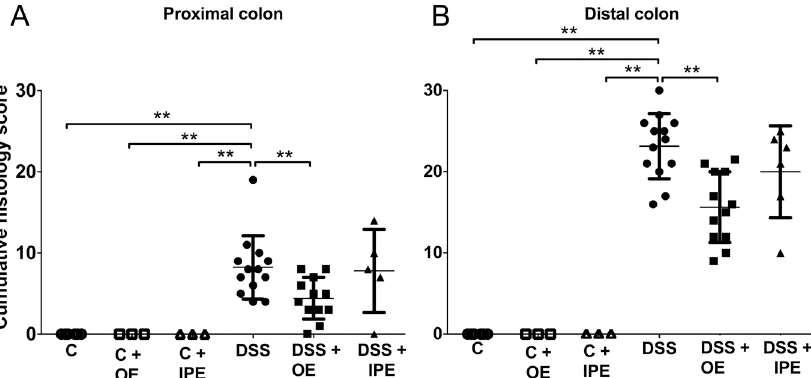
Fig 4. Effect of enoxaparin on histological changes of colon. Cumulative histology damage scores for (A) proximal colon and (B) distal colon. Results are expressed as mean ± SD of n = 3 – 14 mice. ** p < 0.01. Control, C; control with oral enoxaparin, C+OE; control with intraperitoneal injection of enoxaparin, C+IPE; untreated colitis, DSS; colitis with oral enoxaparin, DSS+OE; colitis with intraperitoneal injection of enoxaparin,